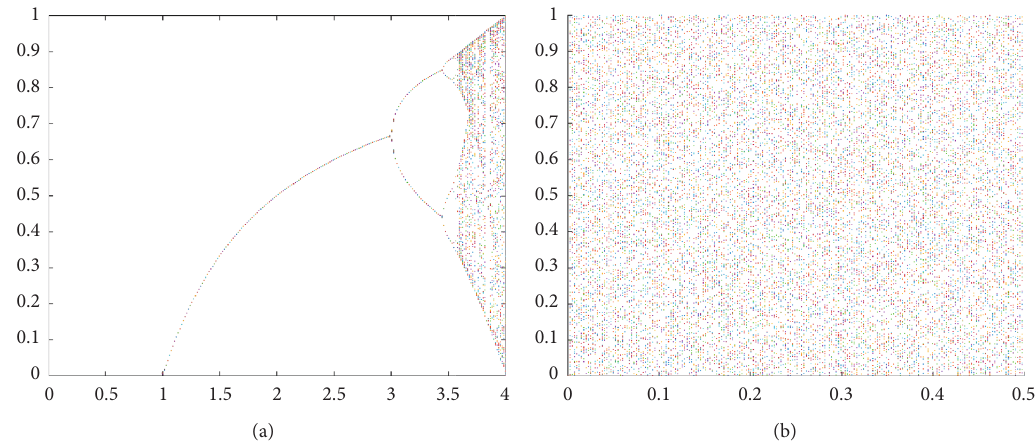
Figure 1: The bifurcation analysis: bifurcations of (a) logistic map and (b) PWLCM.